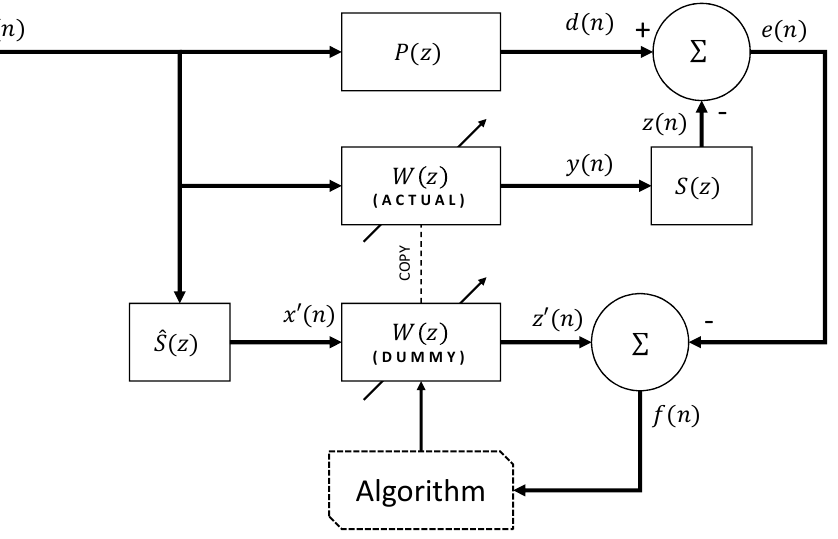
Figure 4. Block diagram used to introduce the proposed